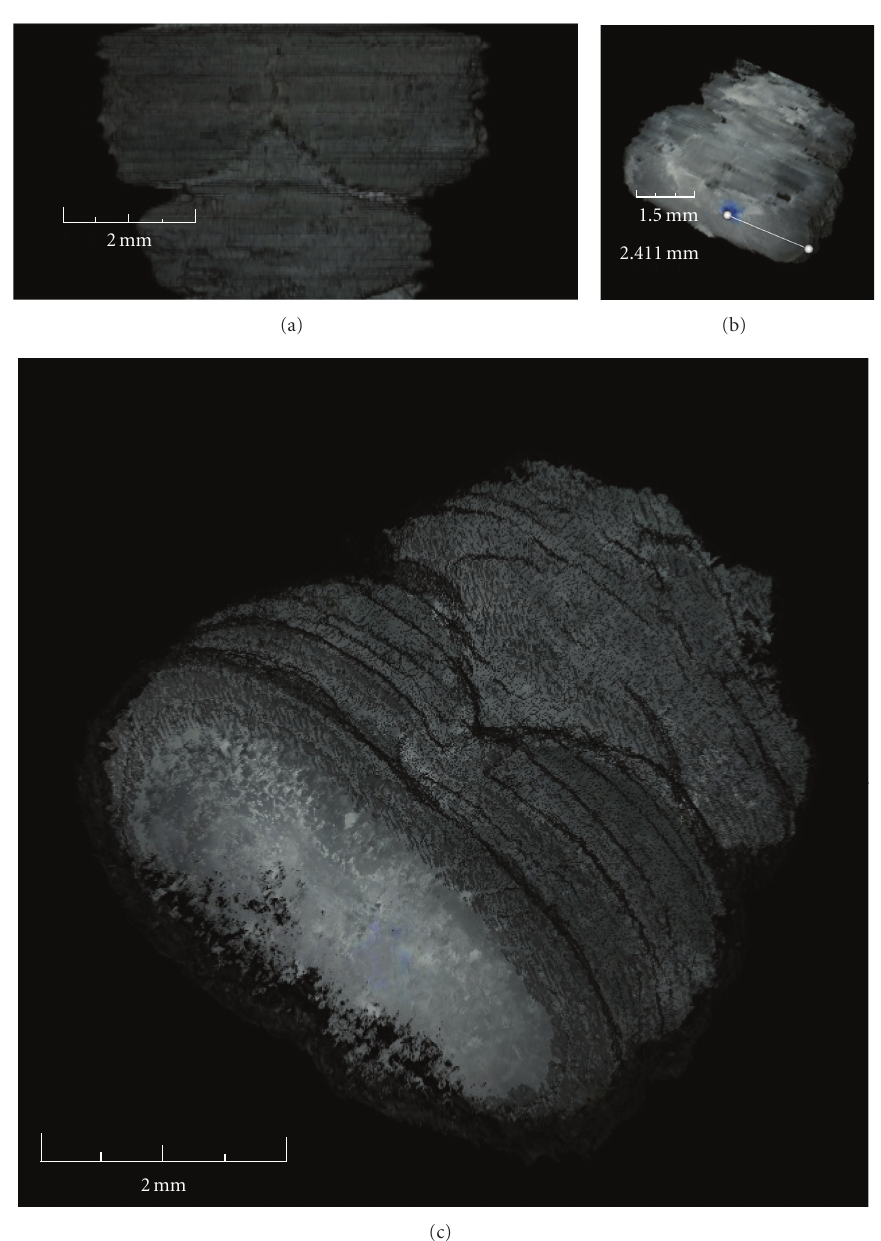
Figure 5: 3D views of the brain model. (a) Superior view of the model. (b) Isometric view of the horizontal section of the brain model. In this image we can see the internal structure of the mouse brain and the distance from the external of the brain to the injection point. (c) Isometric view of the full